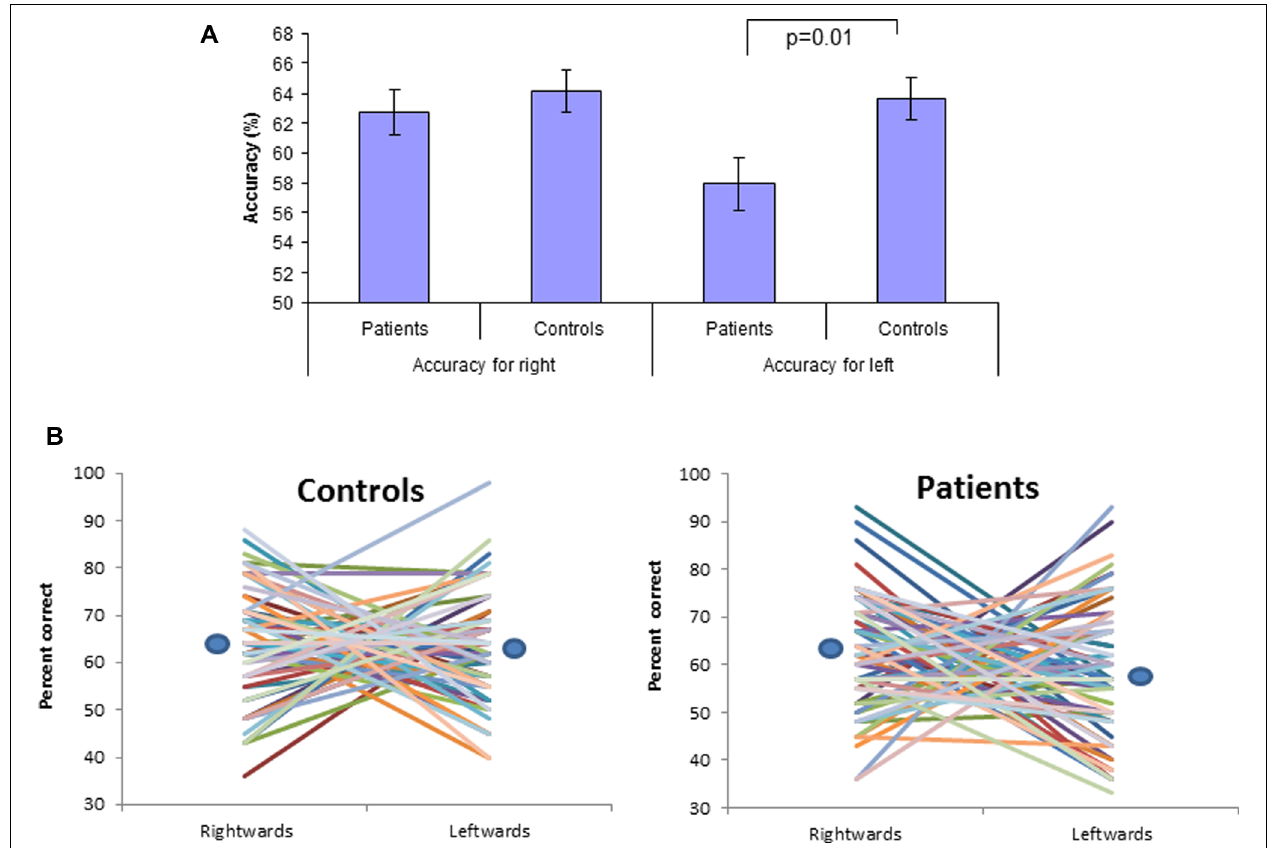
FIGURE 1 | Biological motion direction accuracy. (A) accuracy scores for leftward and rightward motion for the cohort as a whole with a significant difference in accuracy for leftward motion only. (B) The accuracy scores for